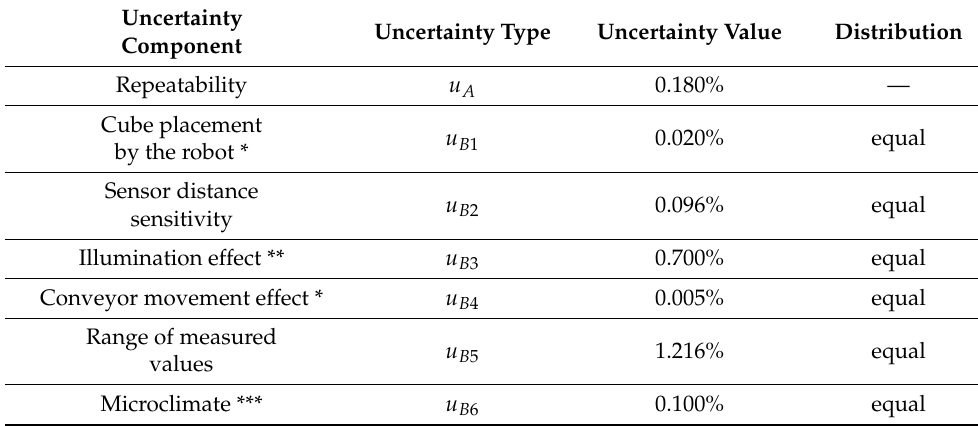
Table 12. Uncertainty sources for the brown